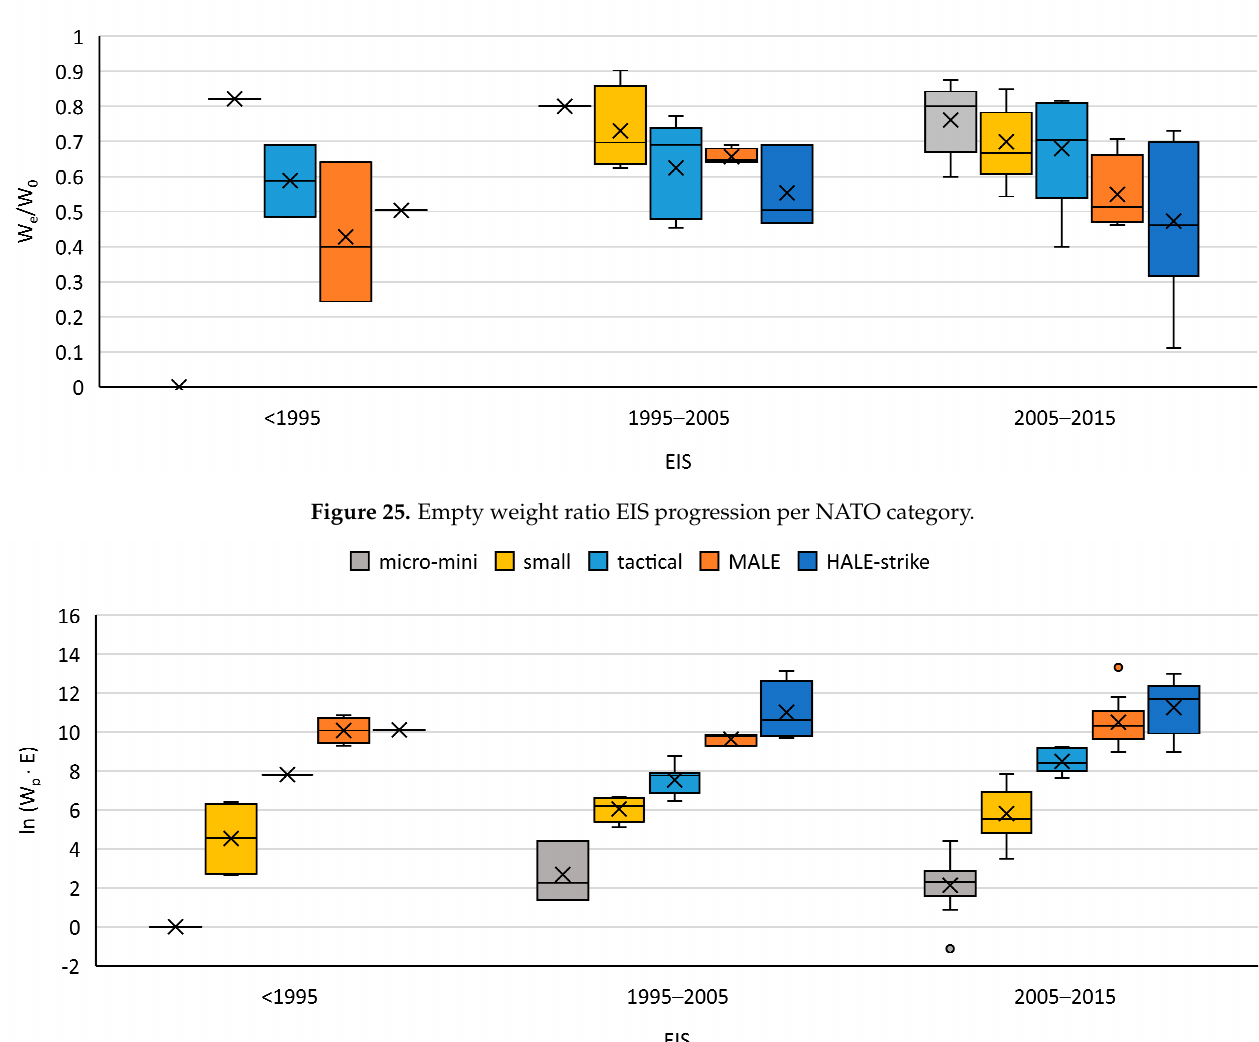
Figure 25. Empty weight ratio EIS progression per NATO category.